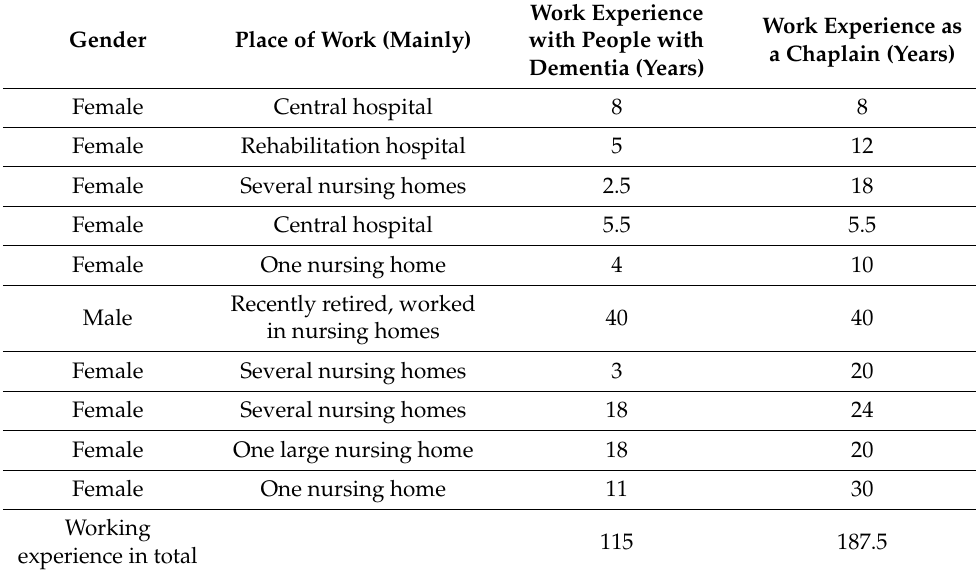
Table 1. Basic characteristics of